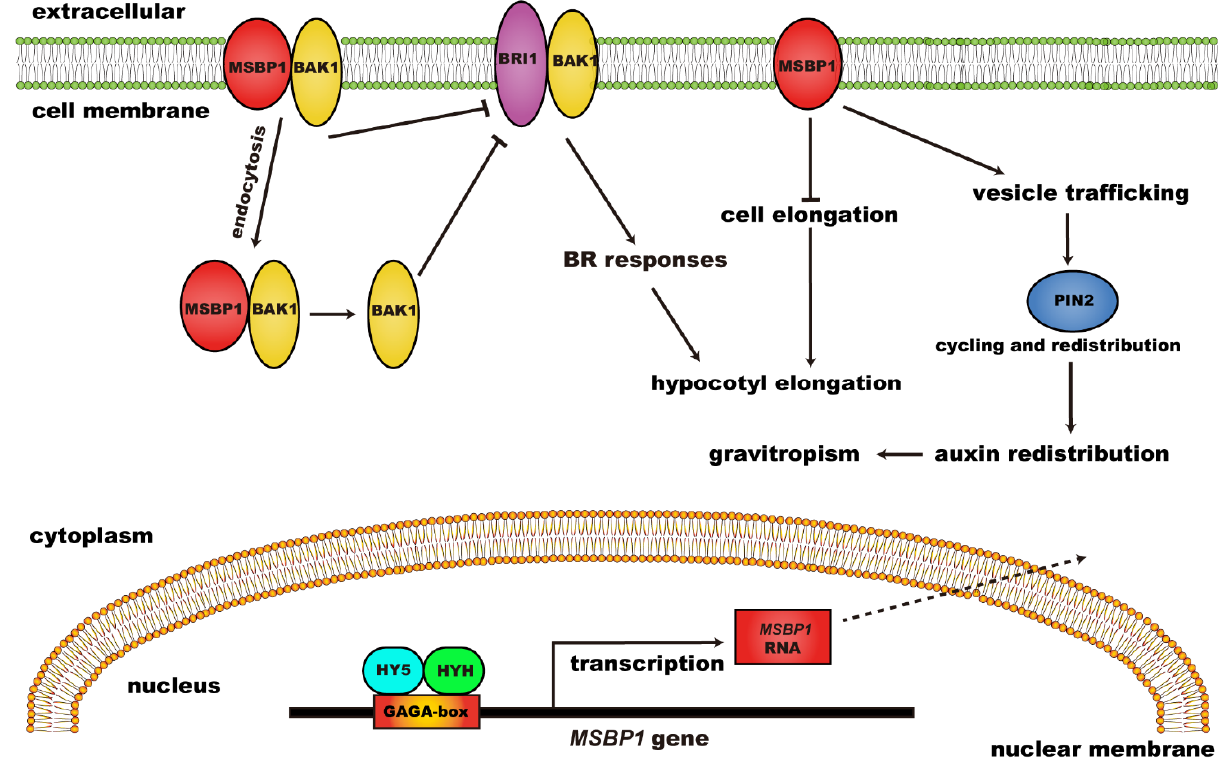
Figure 2. The regulatory function and mechanism of MSBP1 on hypocotyl growth and gravitropism. MSBP1: membrane steroid binding protein 1; BRI1: brassinosteroid-insensitive 1; BAK1: BRI1 associated receptor kinase 1; BR: brassinosteroid; HY5: long hypocotyl 5; HYH: HY5 homolog.